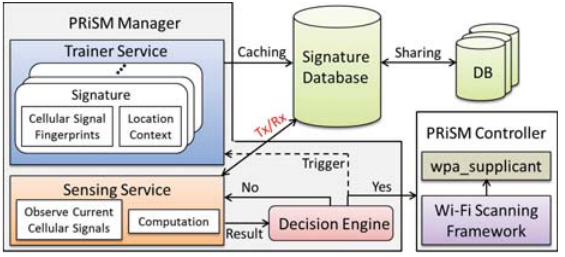
Figure 6: PRiSM system